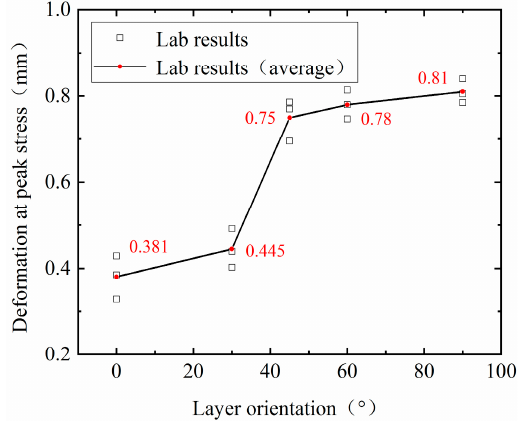
Figure 7. Deformation characteristics of stress peaks.